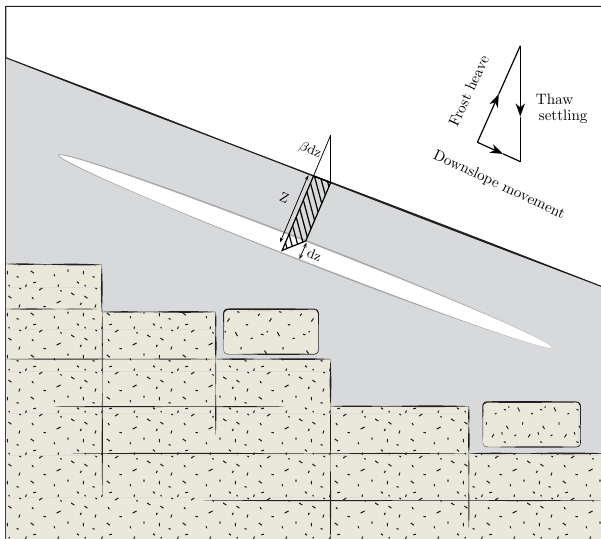
Figure 4. Sketch of the frost-creep mechanism. The downslope movement of sediment (grey) occurs due to the angle discrepancy between frost heave and thaw settling. The white area marks a zone of thickness, d z , that expands and contracts (by β d z ). The downs- lope sediment flux caused by this freeze–thaw event is represented by the hatched area. Note that the expansion has been exaggerated for illustration purposes; in the model β is